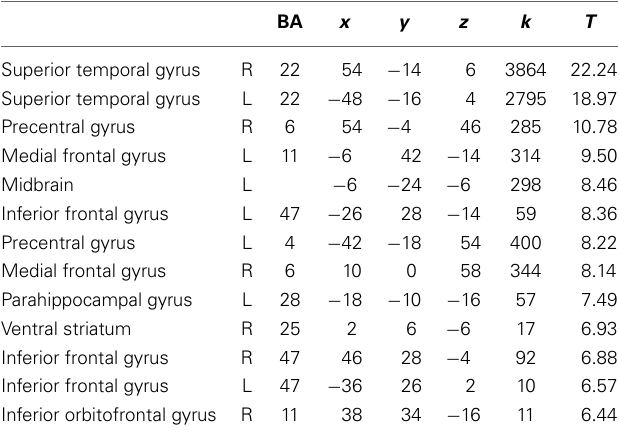
Table 4 | Main effect of emotional vs. neutral music (FWE p < 0.01).